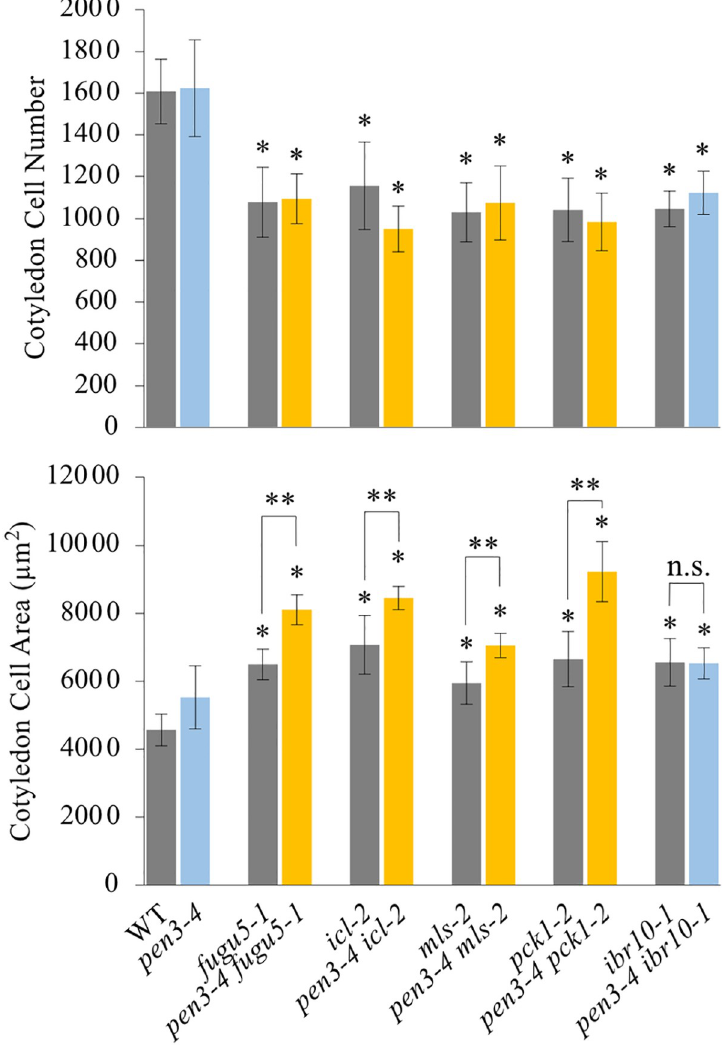
Fig 6. Effect of Increased IBA on Compensated Cell Enlargement in Class II Mutants. Plants were grown on rockwool for 25 DAS; their cotyledons were dissected, fixed in FAA, and cleared for microscopic observations. Data represent cotyledon cell numbers and cotyledon cell areas. Data are means ± SD (n = 8 cotyledons). Single asterisk indicates that the mutant was statistically significantly different compared to the WT ( P < 0.05 by Tukey’s HSD test; R version 3.5.1). Double asterisk indicates that single mutants were statistically significantly different compared to the corresponding double mutants in the pen3–4 background ( P < 0.05 by Tukey’s HSD test; R version 3.5.1). DAS, days after